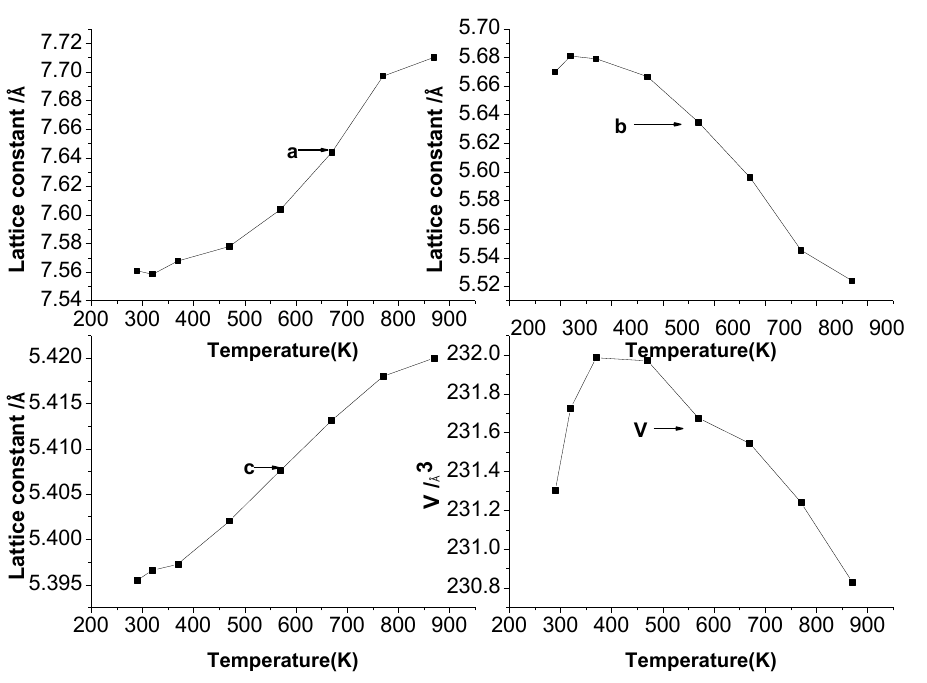
Figure 5. The variation in the Sm 0.85 Sr 0.15 MnO 3- δ lattice parameters and volume with temperature increases.